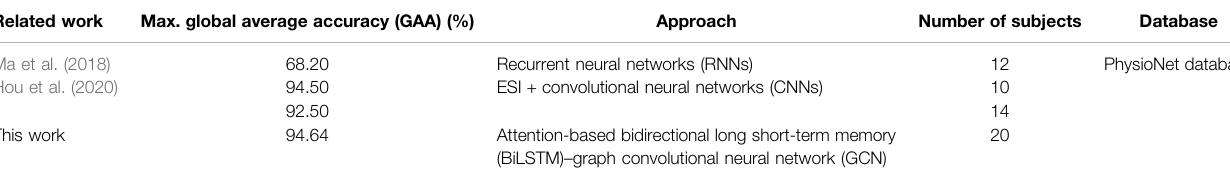
TABLE 1 | Comparison on groupwise